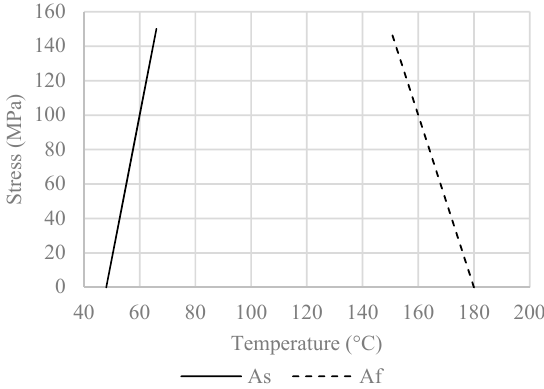
Figure 4. Austenite start and finish range.